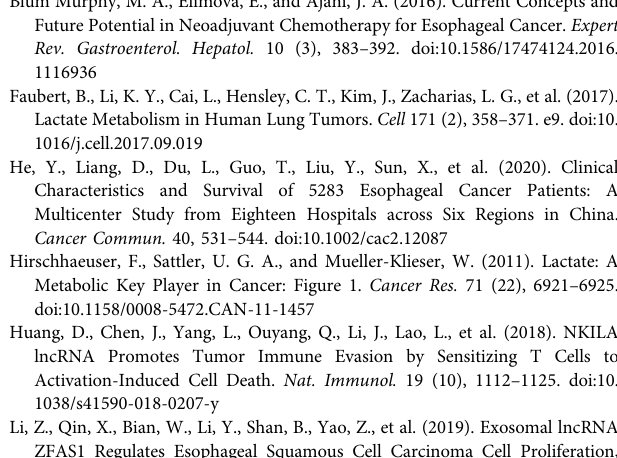
Supplementary Figure S1 | Survival analysis in different TNM stage. (A) Survival analysis of I-II staging in TCGA cohort. (B) Survival analysis of III-IV staging in TCGA cohort. (C) SurvivalanalysisofI-IIstaginginGEOcohort. (D) SurvivalanalysisofIII-IV staging in GEO cohort. Supplementary Figure S2 | C-index of different